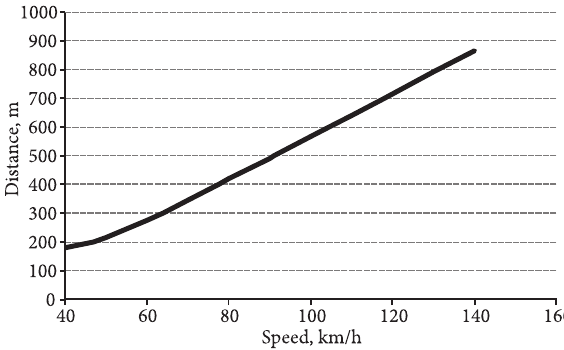
Fig. 3. Critical distances AB between driver and reappeared section according to SNV–640140:1991